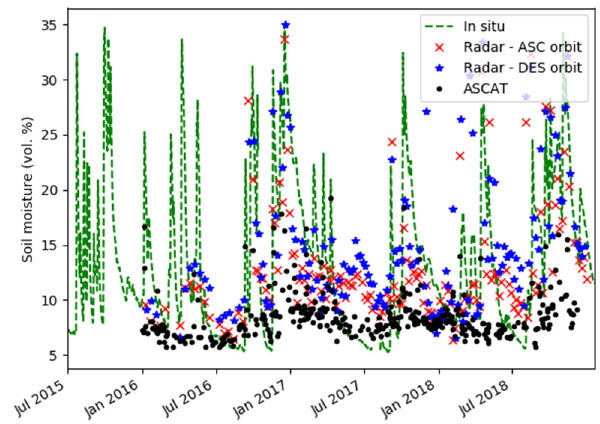
Figure 9. Comparison of surface soil moisture from SMES and ASCAT products, of ground measurements over the INGC site (Tunisia).